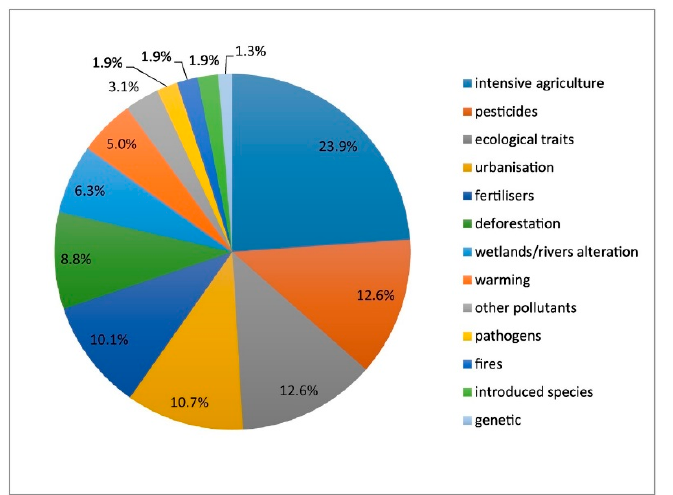
Figure 2. Main factors associated with insect declines according to reports in the literature (from